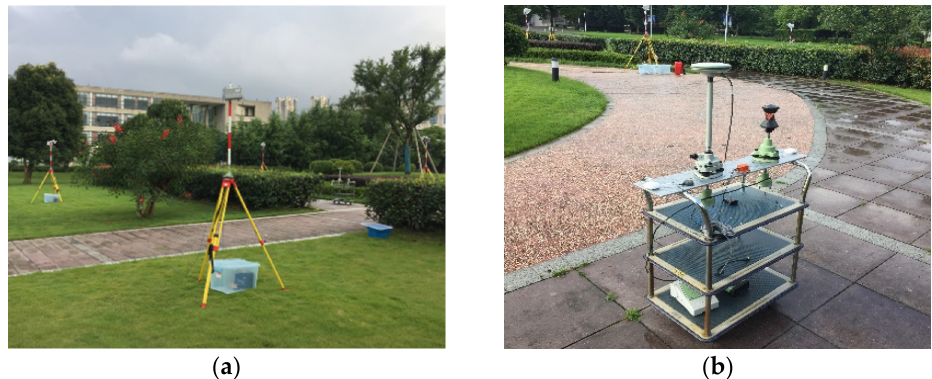
Figure 2. GNSS/UWB experimental scenarios and equipment ( a ) experimental environment; ( b ) Testing platform.